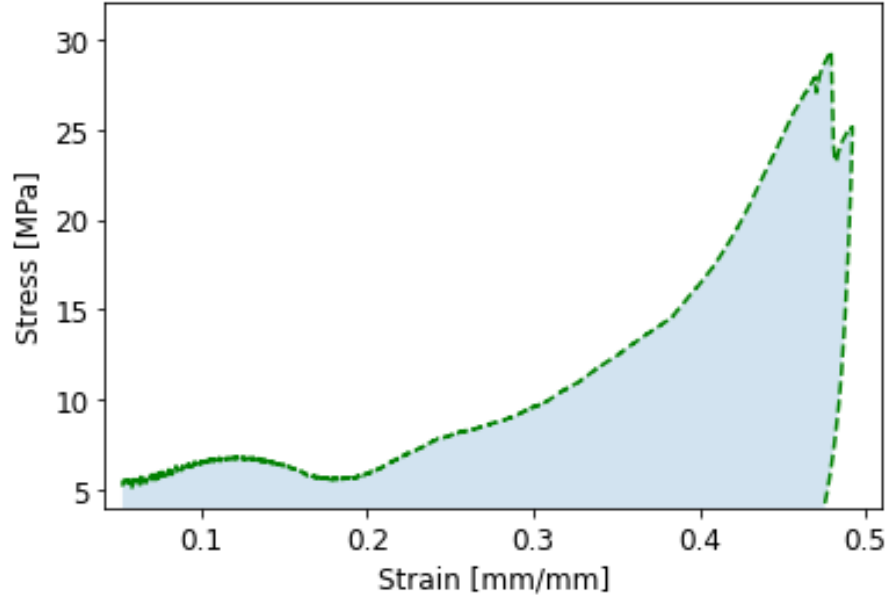
Figure 6. The effective stress-strain curve.